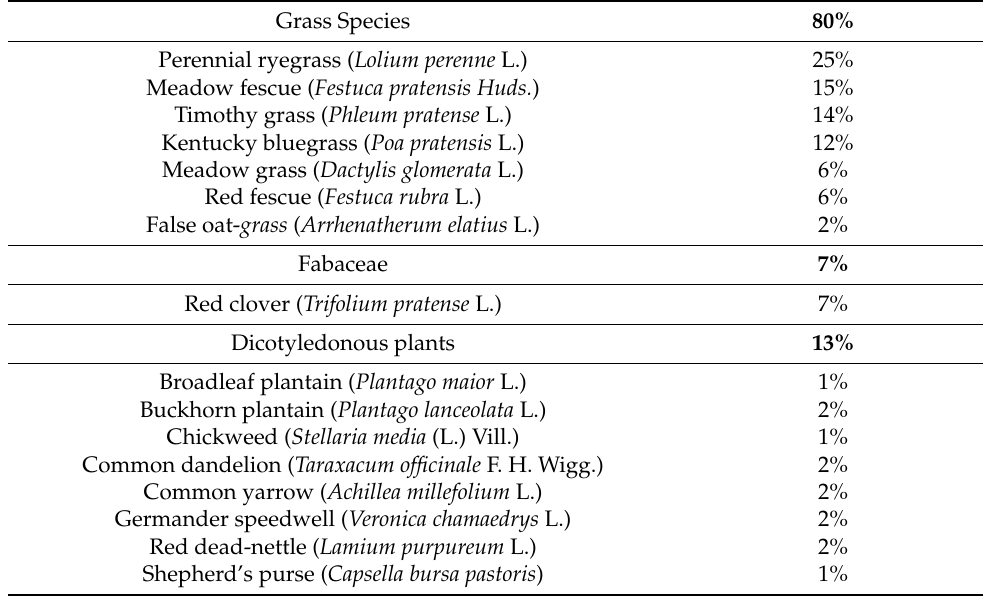
Table 1. Floristic composition of the grassland before the establishment of the experiment. Grass Species 80% Perennial ryegrass ( Lolium perenne L.) 25% Meadow fescue ( Festuca pratensis Huds. ) 15% Timothy grass ( Phleum pratense L.) 14% Kentucky bluegrass ( Poa pratensis L.) 12% Meadow grass ( Dactylis glomerata L.) 6% Red fescue ( Festuca rubra L.) 6% False oat- grass ( Arrhenatherum elatius L.) 2% Fabaceae 7% Red clover ( Trifolium pratense L.) 7% Dicotyledonous plants 13% Broadleaf plantain ( Plantago maior L.) 1% Buckhorn plantain ( Plantago lanceolata L.) 2% Chickweed ( Stellaria media (L.) Vill.) 1% Common dandelion ( Taraxacum officinale F. H. Wigg.) 2% Common yarrow ( Achillea millefolium L.) 2% Germander speedwell ( Veronica chamaedrys L.) 2% Red dead-nettle ( Lamium purpureum L.) 2% Shepherd’s purse ( Capsella bursa pastoris